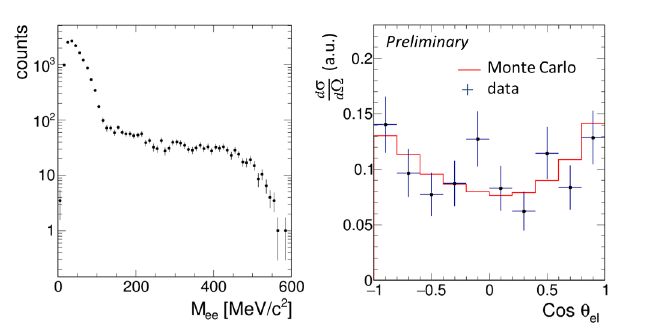
Figure 2. Dilepton production in the π − + CH 2 reaction at 0.69 GeV / c. Left: inclusive e + e − invariant mass distribution. Right: The exclusive π − p → ne + e − reaction is selected using missing mass. The distribution of the lepton angle θ el in the γ ∗ reference frame is shown for γ ∗ angles in the center-of-mass in the bin 0 < cos ( θ CM ) < 0.5. The red curve represents the result of the fit weighted by acceptance and γ ∗ e ffi